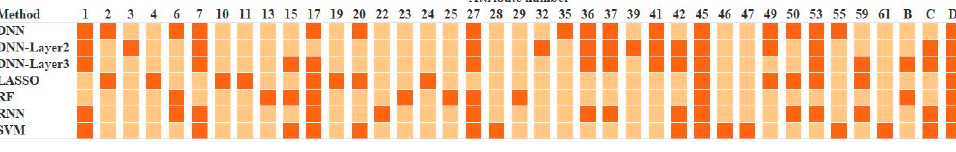
Figure 11. Important factors for risk prediction.